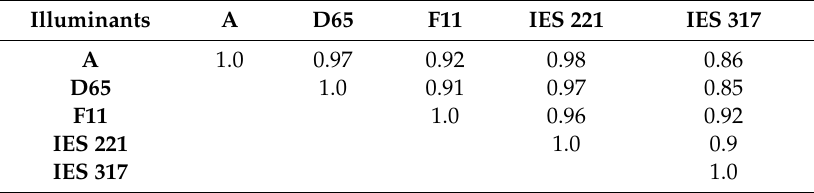
Figure 4. Relative spectral power distributions of CIE illuminants A, F11, D65, IES illuminants #221 (LED Phosphor Blue Pump (53)) and #317 (Tri-band Gaussian). Table 1. Correlation coefficients between the CMMRIs calculated under different illuminants.